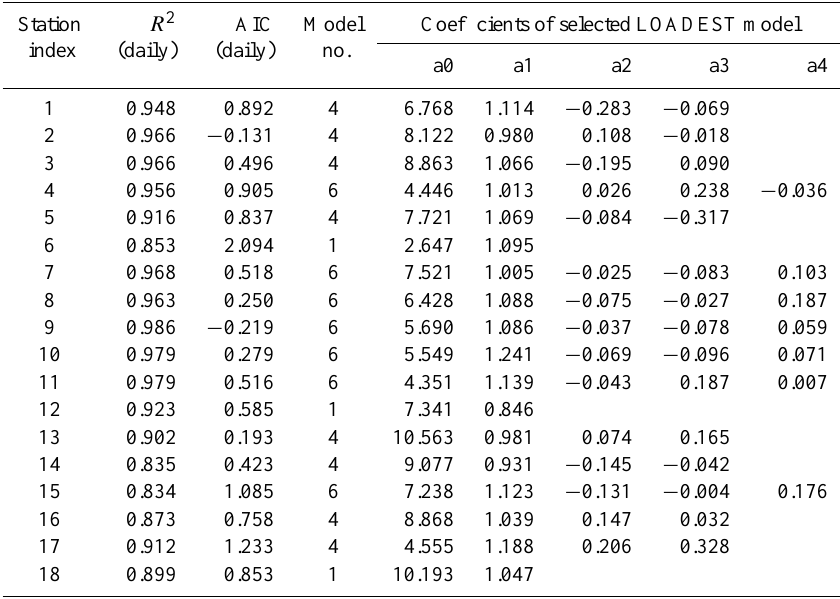
Table 3. Performance of LOADEST model in predicting the observed TN loadings from the WQN database. Models with linear time components (Model no.: 3,5, 7–9) are not